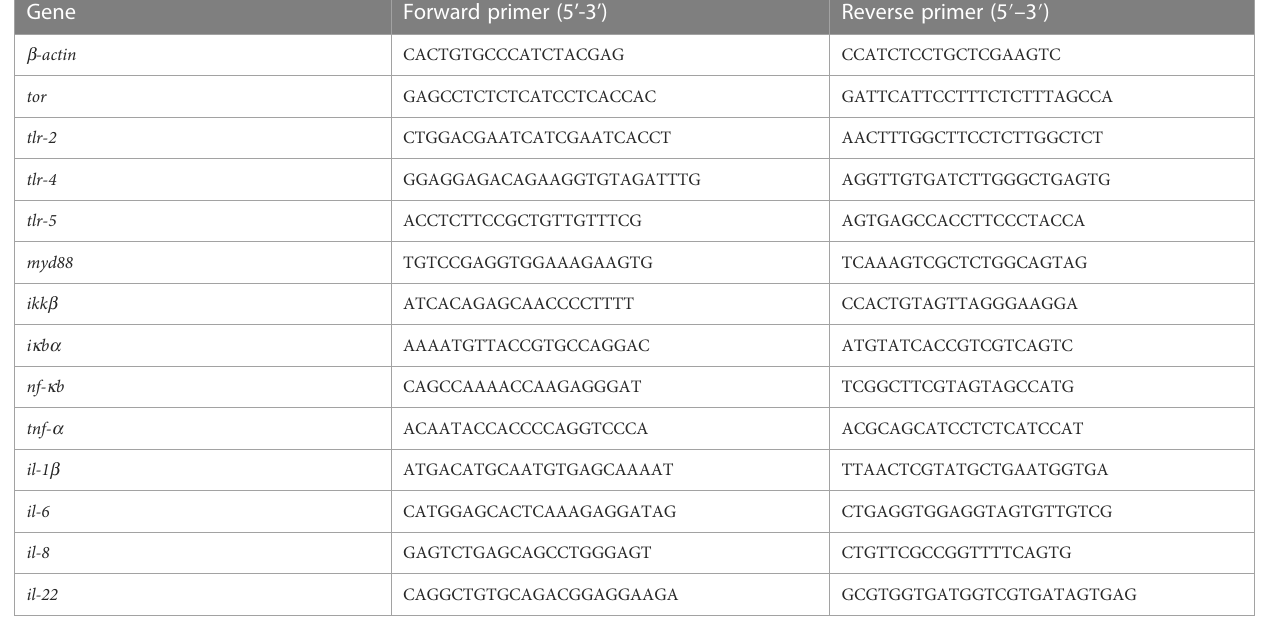
TABLE 3 Primers sequence for RT- q